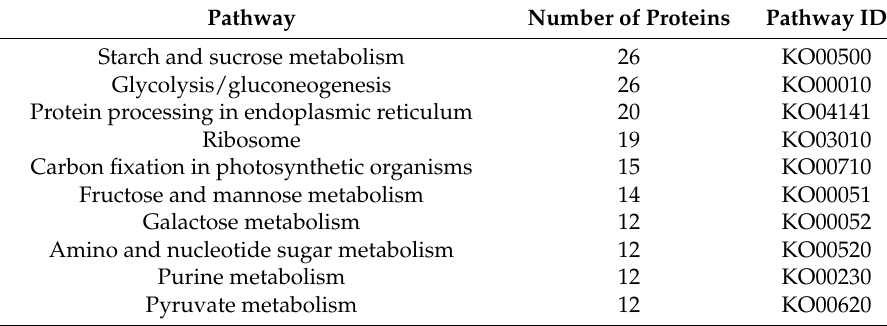
Table 4. Pathway enrichment analysis of differentially expressed